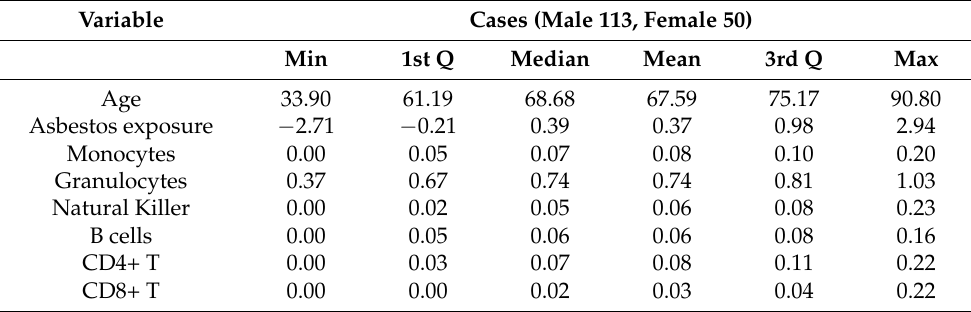
Table 5. Descriptive characteristics of MPM